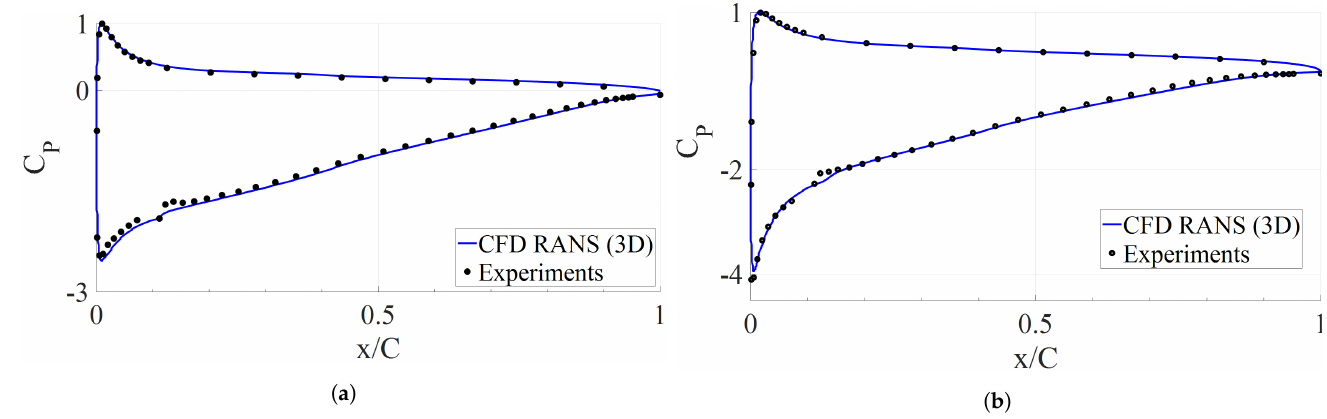
Figure 6. Chord-wise pressure coefficient distribution at mid-height wing section; ( a ) AOA = 8 ◦ , ( b ) AOA = 11 ◦ . The results are from the the simulation of the 3D